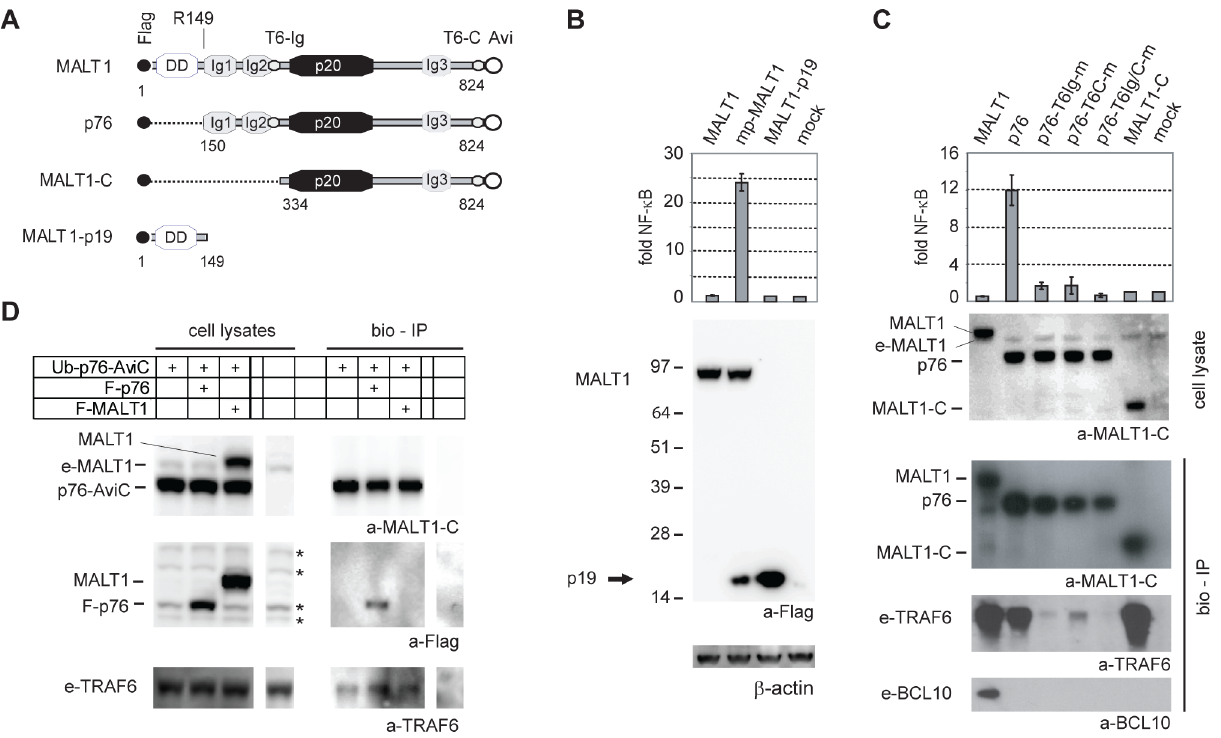
Figure 4. MALT1 p76 activates NF- k B signalling in 293T cells. A) Features of Flag-tagged MALT1, p76, MALT1-C and MALT1-p19. Numbers indicate the start and stop AA position for p76, MALT1-C and MALT1-p19 relative to the MALT1 protein sequence (Refseq NP_006776.1, 824 AA). B-C) NF- k B-reporter assays of 293T cells transiently expressing MALT1, mp-MALT1, MALT1-p19, p76 and mutants or MALT1-C. NF- k B-dependent luciferase activity is shown as fold induction of vector-transfected cells and represents the mean + /- S.D. (n=3). Immunoblot of cell lysates with a-Flag – a- b - actin shows equal expression/loading of the different MALT1 constructs (B) and a-MALT1-C (C) shows equal expression of the different MALT1 constructs. Bottom (C): streptavidin pull-down (bio-IP) of MALT1, p76 or MALT1-C, transiently expressed in 293T cells, and immunoblotted with a- MALT1C, a-TRAF6 and a-BCL10 antibodies. e-MALT1, e-TRAF6, e-BCL10: endogenous MALT1, TRAF6 and BCL10. D) immunoblot of bio-IPs of Avi- tagged Ub-p76 expressed together with Flag-p76 or Flag MALT1 with a-MALT1-C, a-Flag and a-TRAF6. * indicate non-specific